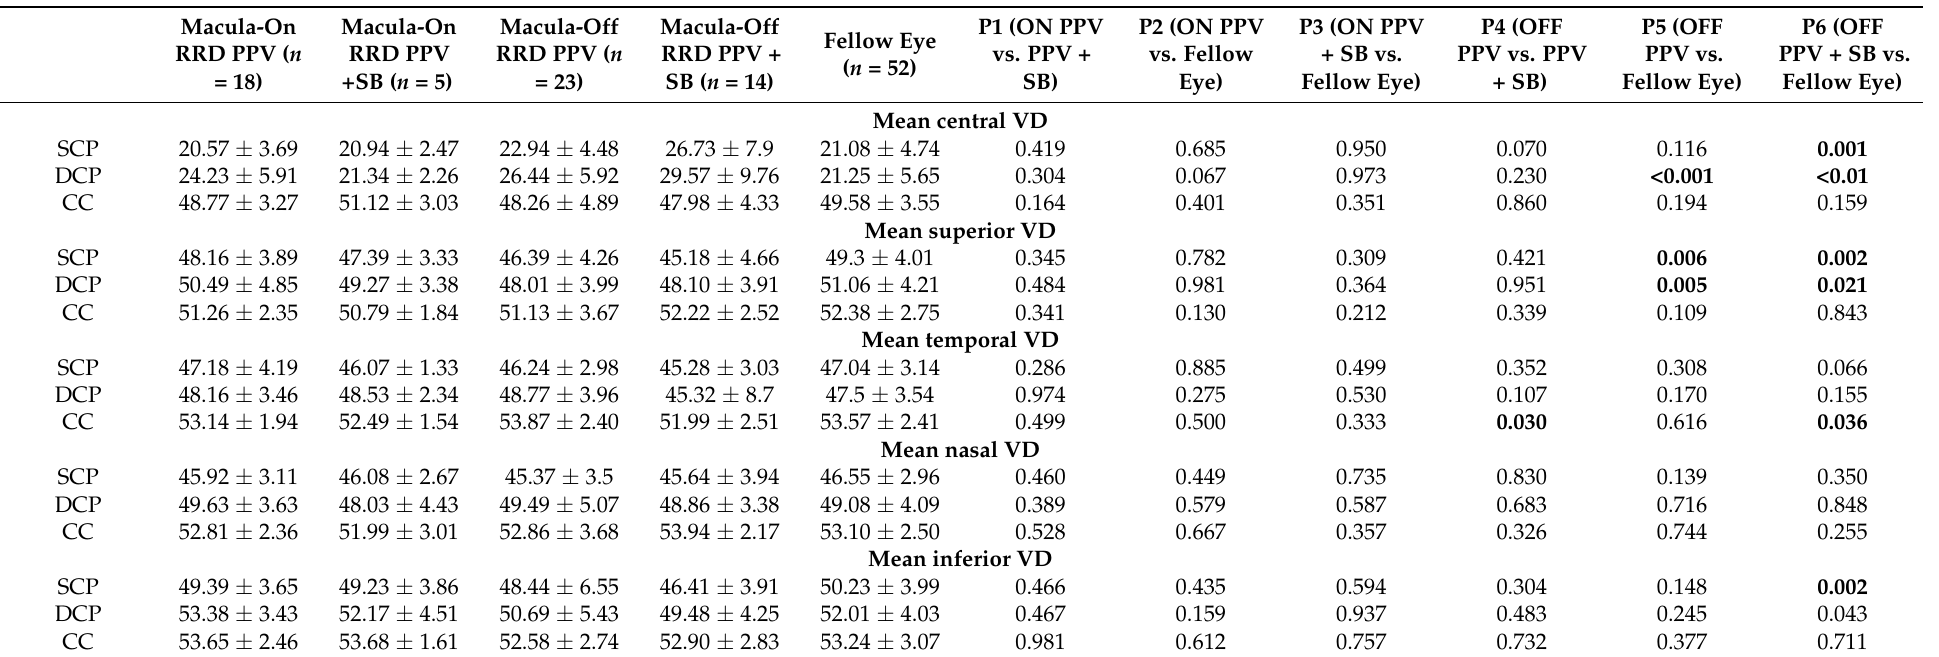
Table 2. Vessel density (VD) in superficial and deep retina capillary plexuses (SCP, DCP) and choriocapillaris plexus (CC) measured with Deep-Range Imaging (DRI)-Triton OCTA in macula-on RRD and macula-off RRD eyes, depending on the surgical procedure, and control